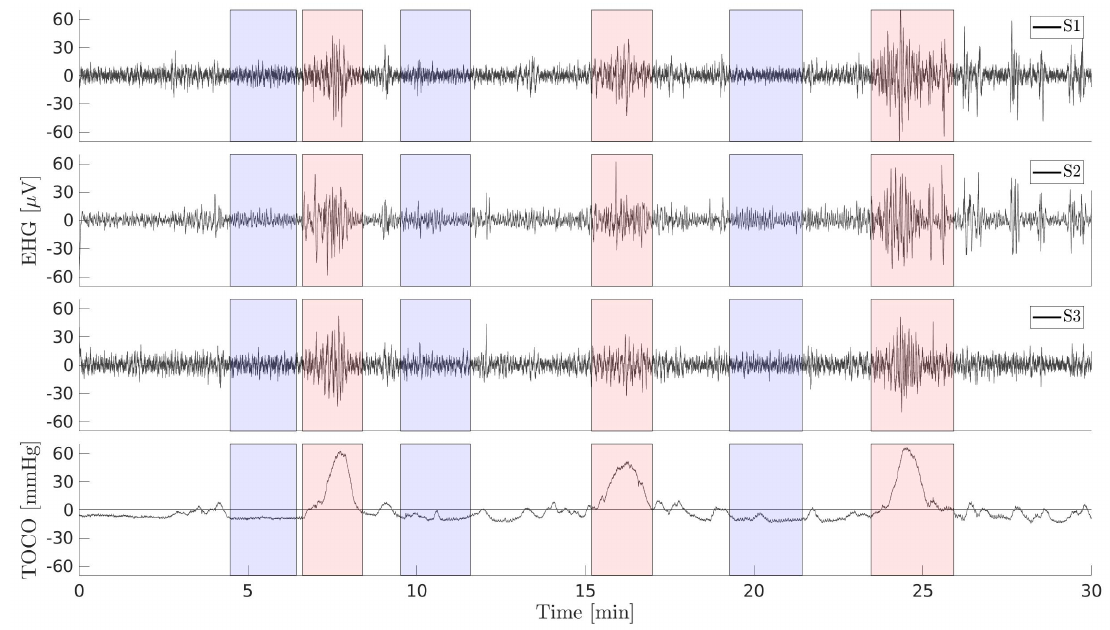
Figure 2. The electrohysterogram (EHG) and external tocogram (TOCO) signals of the record tpehgt_p008 (preterm, delivery in the 32nd week, recorded in the 26th week of pregnancy). Blue: human-annotated dummy intervals, red: human-annotated contraction